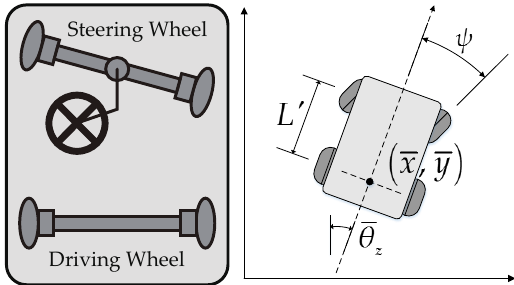
Figure 7. A car-like vehicle and its kinematic model.